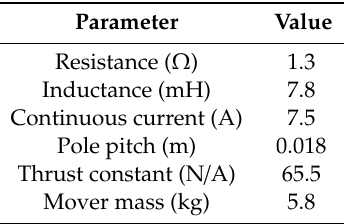
 * d i PI v* Figure 8. Block diagram of the position-sensorless control system based on high-frequency square- wave voltage injection. With the help of the fast Fourier transform tool in MATLAB/Simulink, spectrum analysis of current is given. Figure 9 shows the frequency spectrum comparison of ˆ q i before and after signal filtering in simulation which verifies the effect of FIR filter and signal separation. In PMLSM, 0 Hz, 10 kHz, and 20 kHz components were the main interference in q -axis current, which is shown in